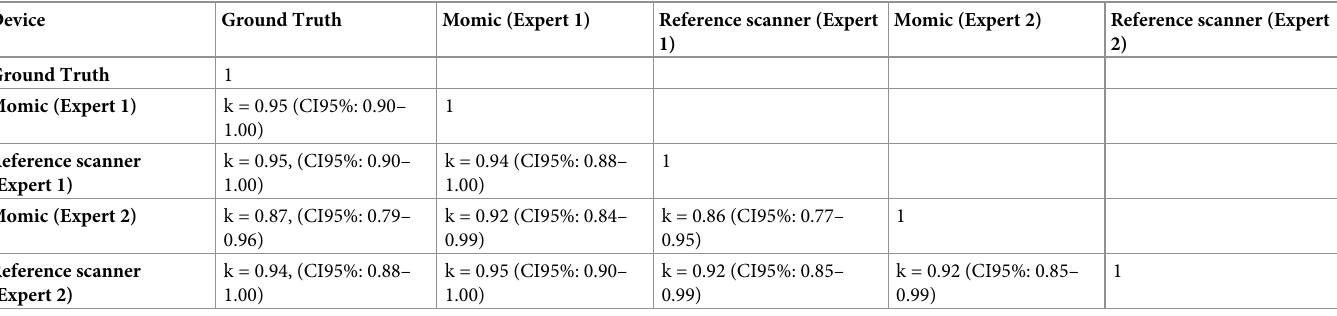
Table 2. Agreement of results for detection of metastases in slides scanned with the miniature microscope scanner and the reference slide